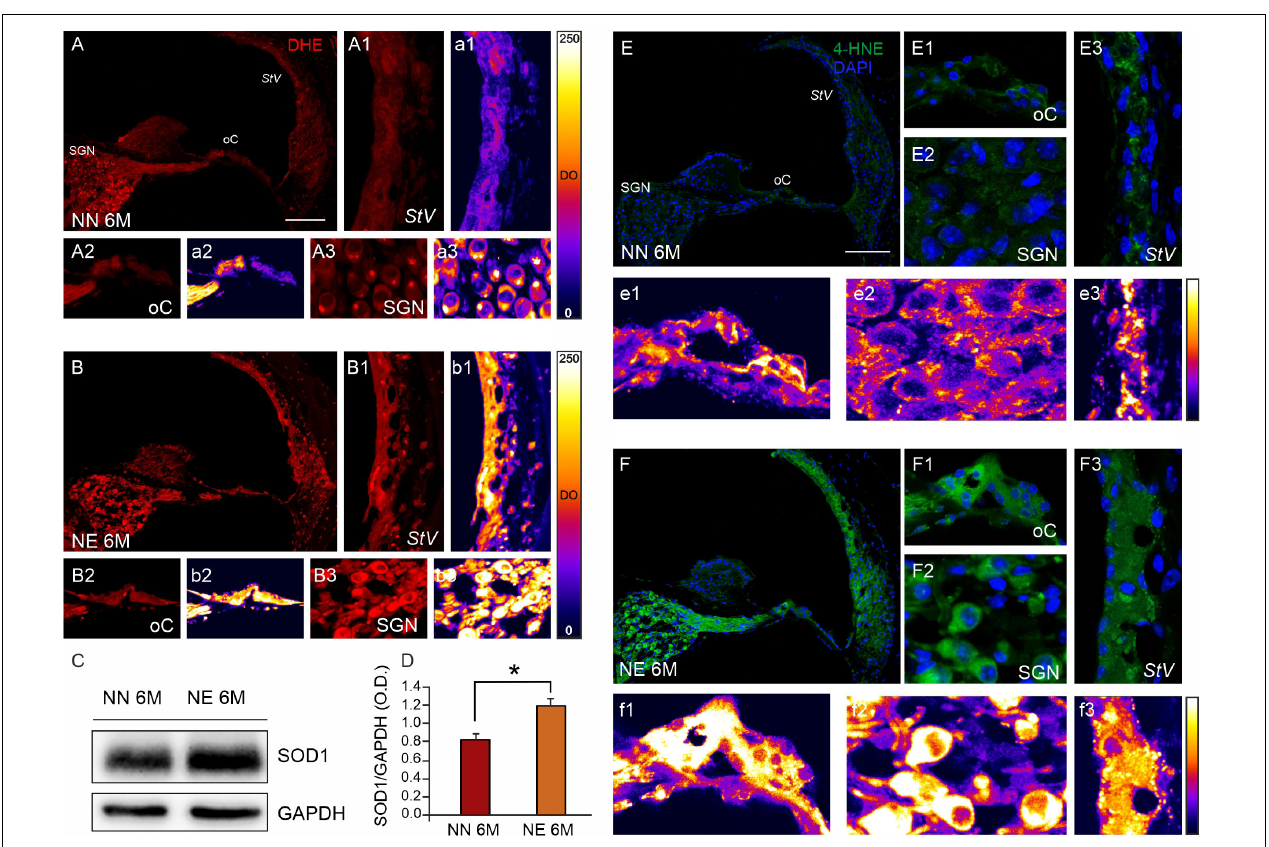
FIGURE 5 | Noise exposure accelerates cochlear oxidative stress and lipid peroxidation in 6 M mice with ARHL. (A,B) Representative images of cochlear cryosections (middle turn region) of no noise- exposed [NN group; (A) ] and noise-exposed [NE group; (B) ] animals of 6 months of age (M) stained with DHE (red fluorescence). ROS fluorescence increases in noise-exposed animals in all cochlear structures. High magnifications of stria vascularis (A1,B1) , the organ of Corti (A2,B2) , and spiral ganglion neurons (A3,B3) are shown. The distribution of fluorescence signals in a pseudo-color rainbow scale is shown in the stria vascularis (a1,b1) , the organ of Corti (a2,b2) , and spiral ganglion neurons (a3,b3) . StV , stria vascularis ; oC, organ of Corti; SGNs, spiral ganglion neurons. Scale bar: 100 µ m. (C) Western immunoblotting indicating SOD1 overexpression in cochlear samples of NE animals of 6 M. (D) Histograms (mean ± SEM) represent relative optical density (O.D.) values (SOD1/GAPDH ratios). Experiments were performed in triplicate. Asterisks indicate significant differences between groups (* p < 0.05) from Student’s t -test. (E,F) Representative images showing cochlear cryosections (middle-basal turns) of not-exposed [NN; (E) ] and noise-exposed animals [NE; (F) ] of 6 M stained with 4-HNE (green fluorescence) and DAPI (blue fluorescence). High magnifications of the organ of Corti (E1,F1) , spiral ganglion neurons (E2,F2) , and stria vascularis (E3,F3) are shown. The distribution of fluorescence signals in a pseudo-color rainbow scale is shown in the organ of Corti (e1,f1) , spiral ganglion neurons (e2,f2) , and stria vascularis (e3,f3) . StV , stria vascularis ; oC, organ of Corti; SGNs, spiral ganglion neurons. Scale bar: 100 µ